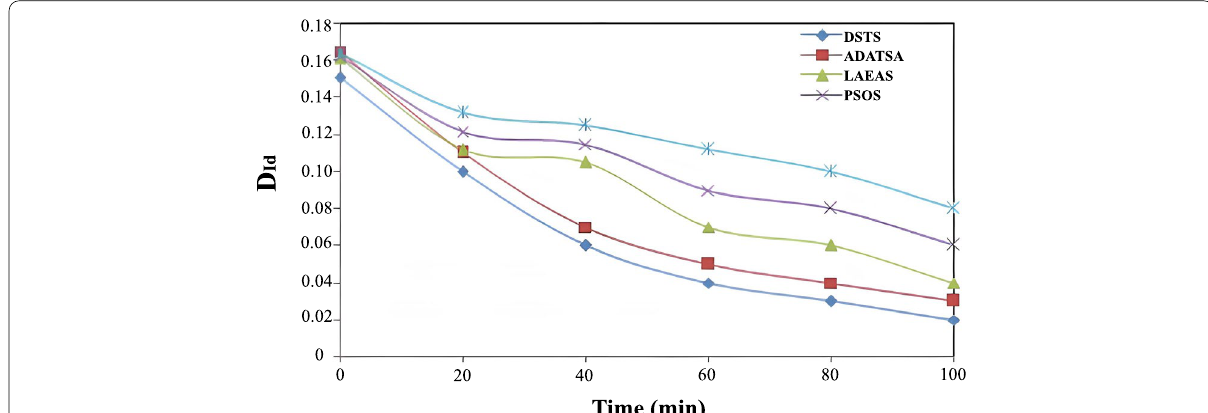
Fig. 8 Comparative analysis of resource imbalance degree (D Id ) with time (Task-4)